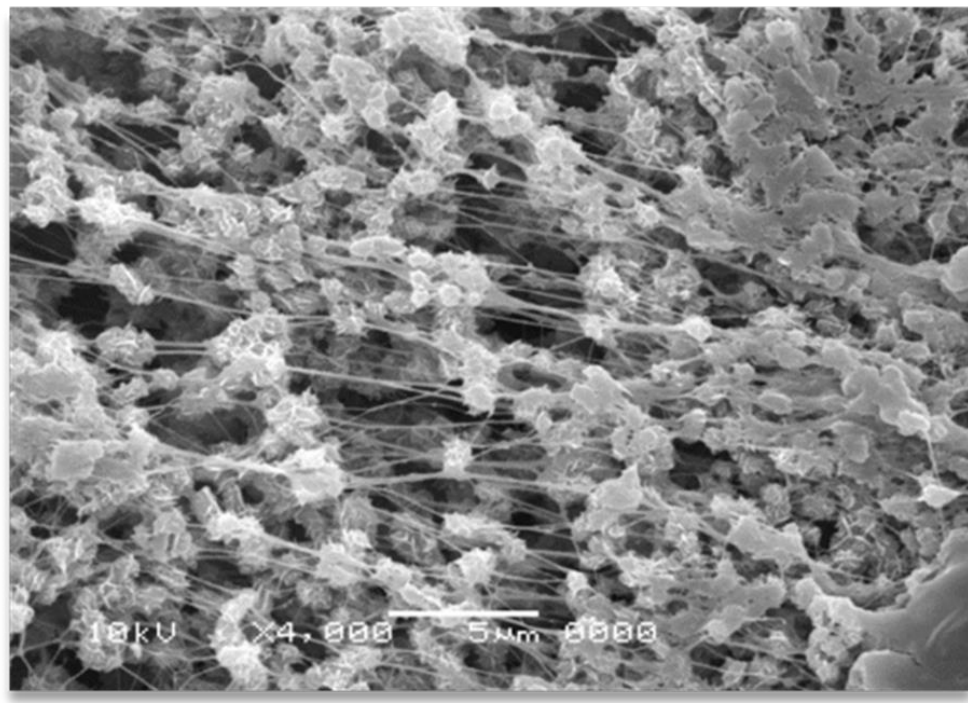
Figure 1. SEM micrographs of dis-UHMWPE powder grains sintered at 30 °C under 60 atm (without any melting) and subjected to slight tensile deformation during removal from the mold.